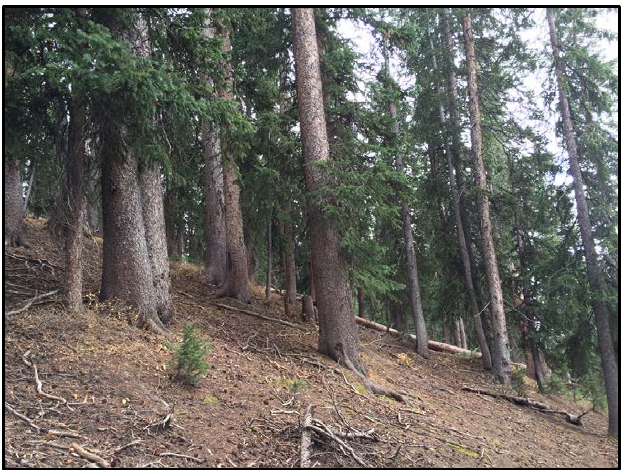
Figure 2. Pure, mature Engelmann spruce at about 3000 m elevation in the Tushar Mountains, Fishlake National Forest, Central Utah. This stand has no history of management and essentially no resistance nor resilience to spruce beetle attack.